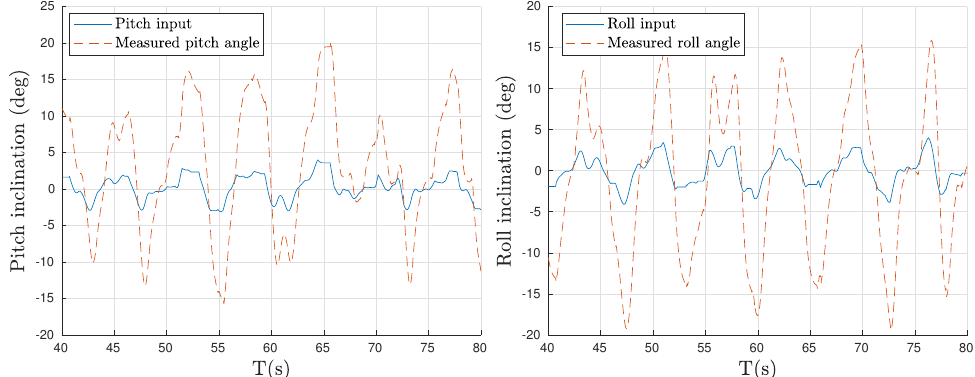
Figure 5. Examples of decoupled identification datasets. Redefined input targets compared to measured angles for pitch ( left ), and roll ( right ).